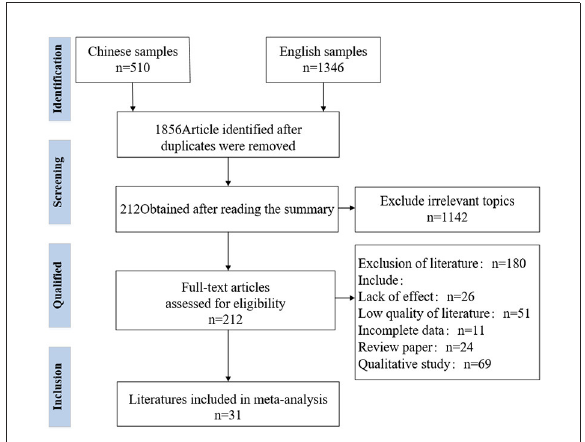
FIGURE2 PRISMA literature screening diagram (according to the inclusion criteria, we finally got 31 pieces of literature related to our research to make a